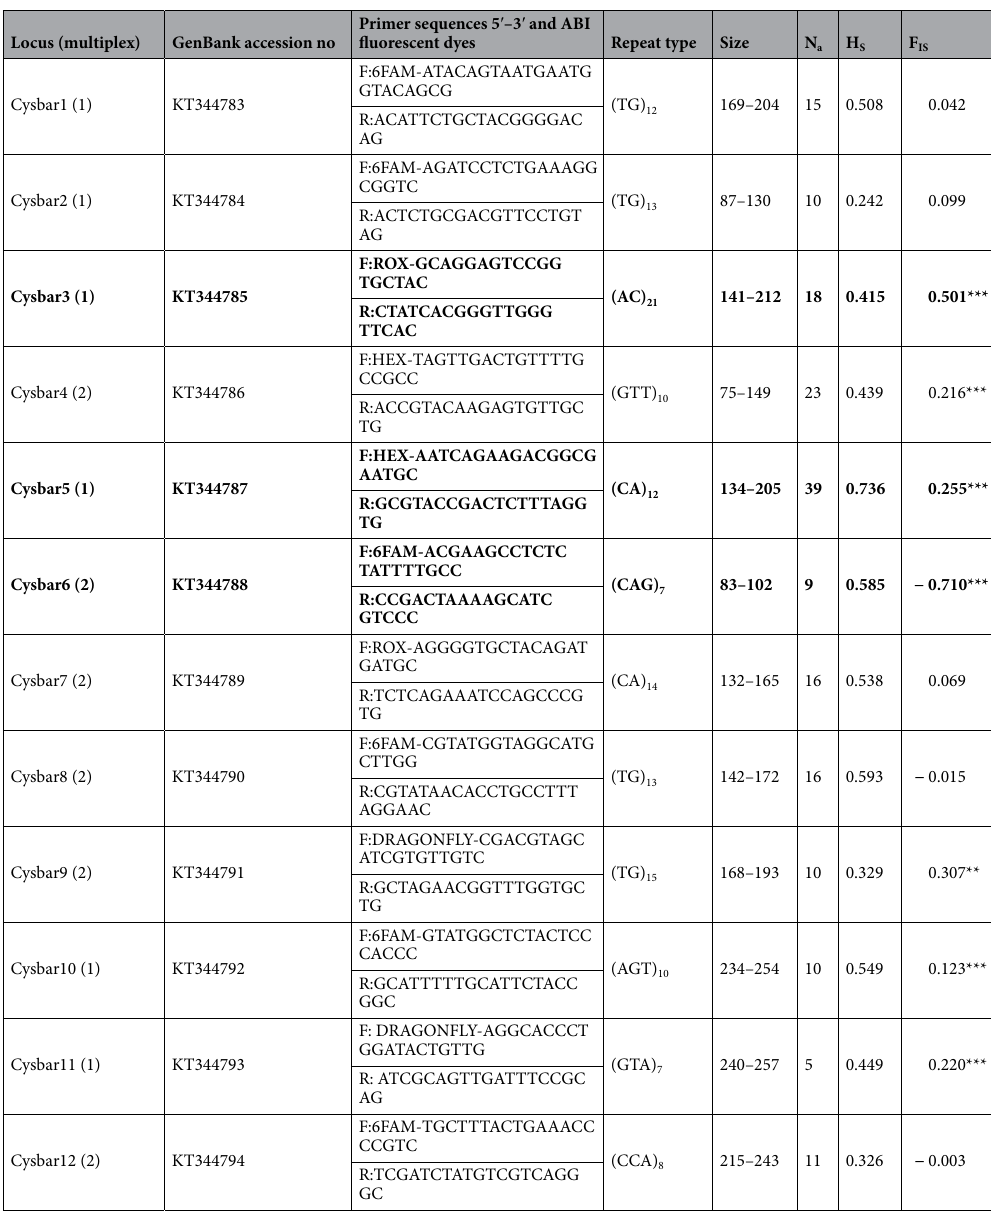
Genetic structure within the Ionian and Adriatic Seas. A strong and significant heterozygote defi- ciency was observed with f = 0.103 ( p -value < 10 –3 ). High and significant genetic differentiation was observed among all subsamples across loci (θ = 0.313, p -value < 10 –3 , ENA corrected F ST = 0.278, IC = [0.208, 0.341]). The F IS variation across loci was higher than the variation observed among all subsamples (Fig. 2), the Pearson cor- relation between F IS and F ST was not significant (r(F IS ,F ST) = − 0.133 p -value = 0.733), and the standard error of F IS (StrdErrFIS = 0.066) was 1.5 higher than for F ST (StrdErrFST = 0.043). No correlation was observed between the number of missing data and F IS values (ρ = − 0.017, p -value = 0.517). Further, within the Ionian and Adriatic Seas, a strong structuration was revealed by the clustering analyses. Again, different values of K were explored (from two to ten, results provided in SI3) and K = 3 (Fig. 3b) provided the best meaningful results (ΔK